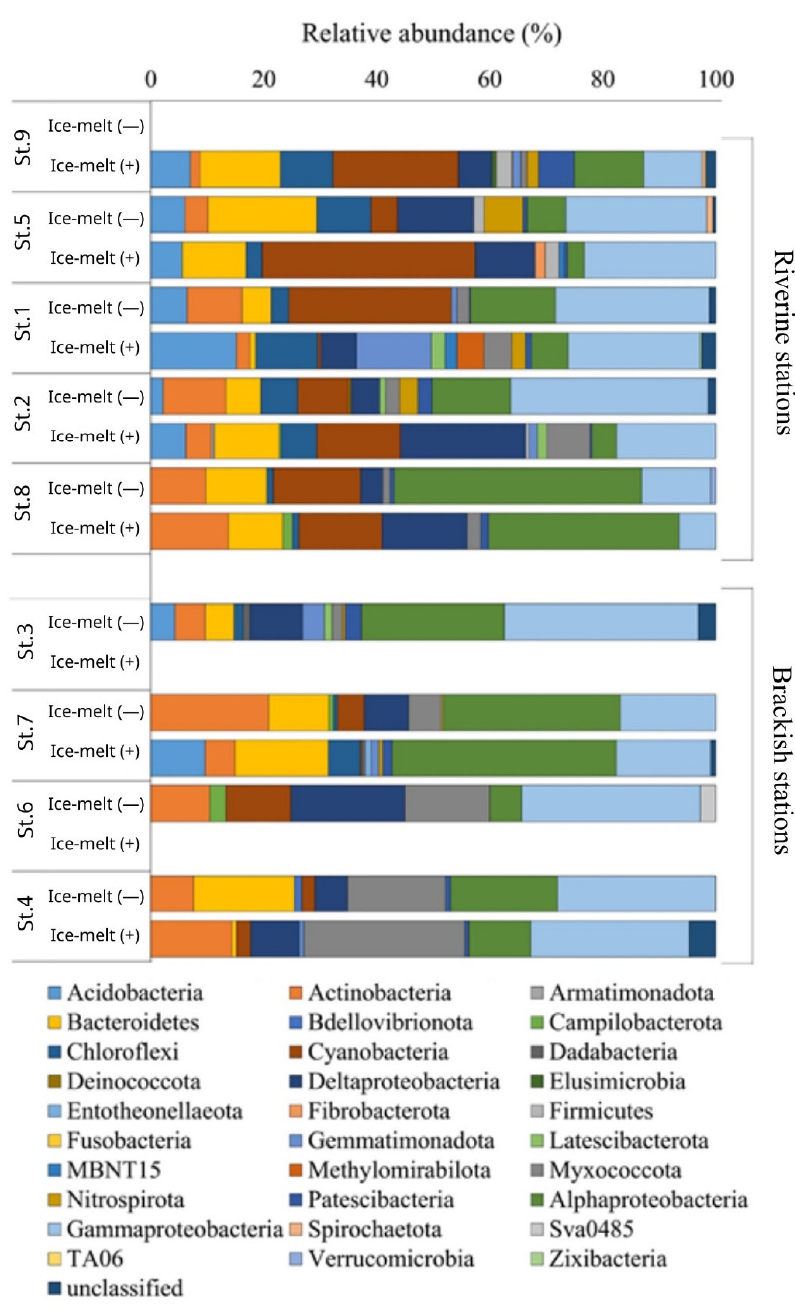
Figure 4. Phylogenetic affiliation of Arctic bacteria retrieved at riverine and brackish stations.